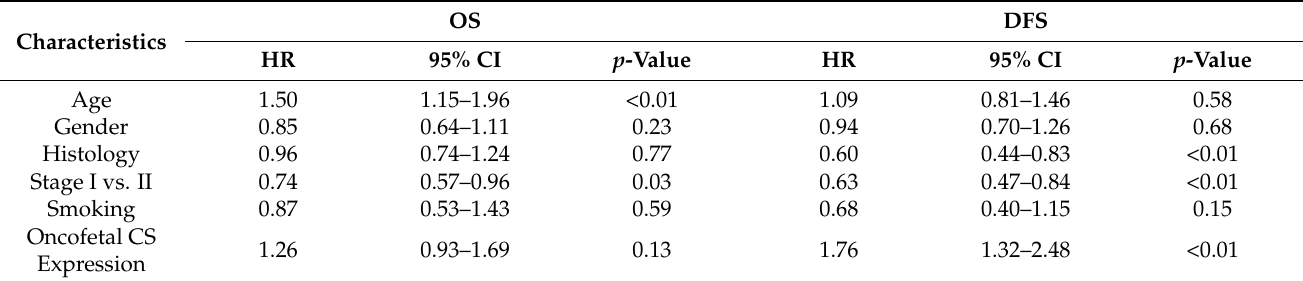
Table 3. Multivariable Cox regression analyses of overall and disease-free